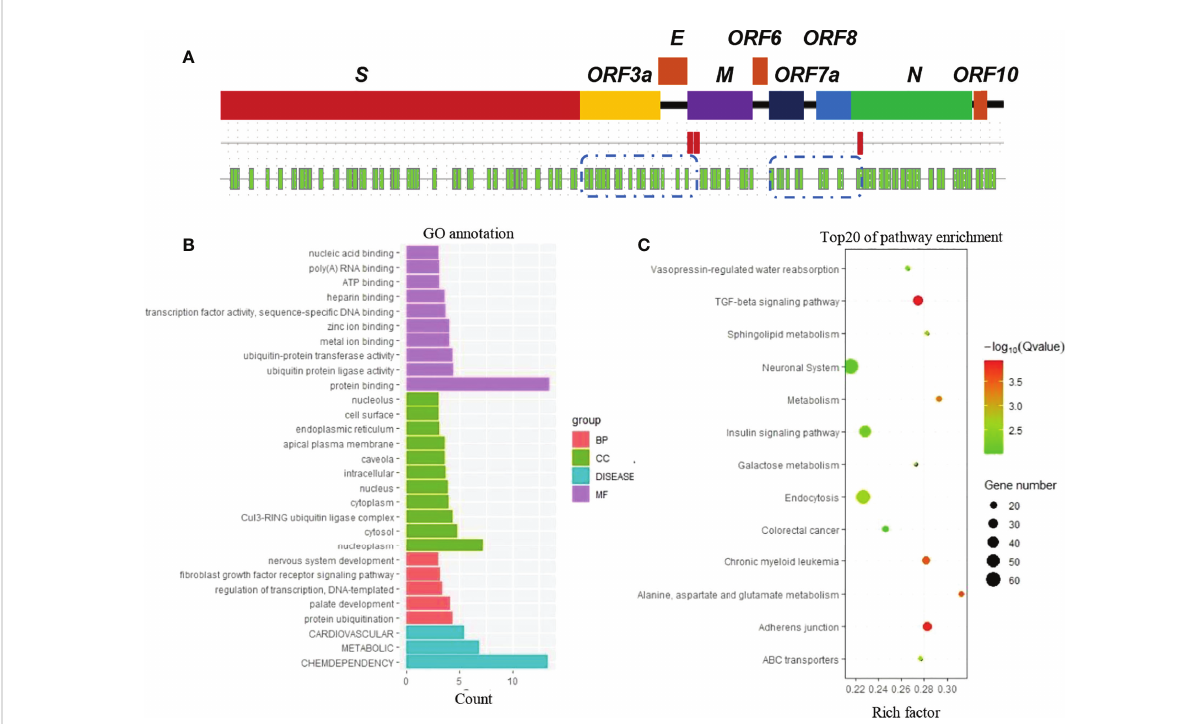
FIGURE 1 Prediction of human miRNAs binding to SARS-CoV-2 RNA. (A) Genome map of SARS-CoV-2 ( fi rst line), potential PolyA sites (red block in the second line), and potential miRNA binding sites (green blocks in the third line). (B) Gene classi fi cation. Genes are the predicted targets of miRNAs that have a predicted interaction with SARS-CoV-2 RNA. (C) Kyoto Encyclopedia of Genes and Genomes (KEGG) enrichment